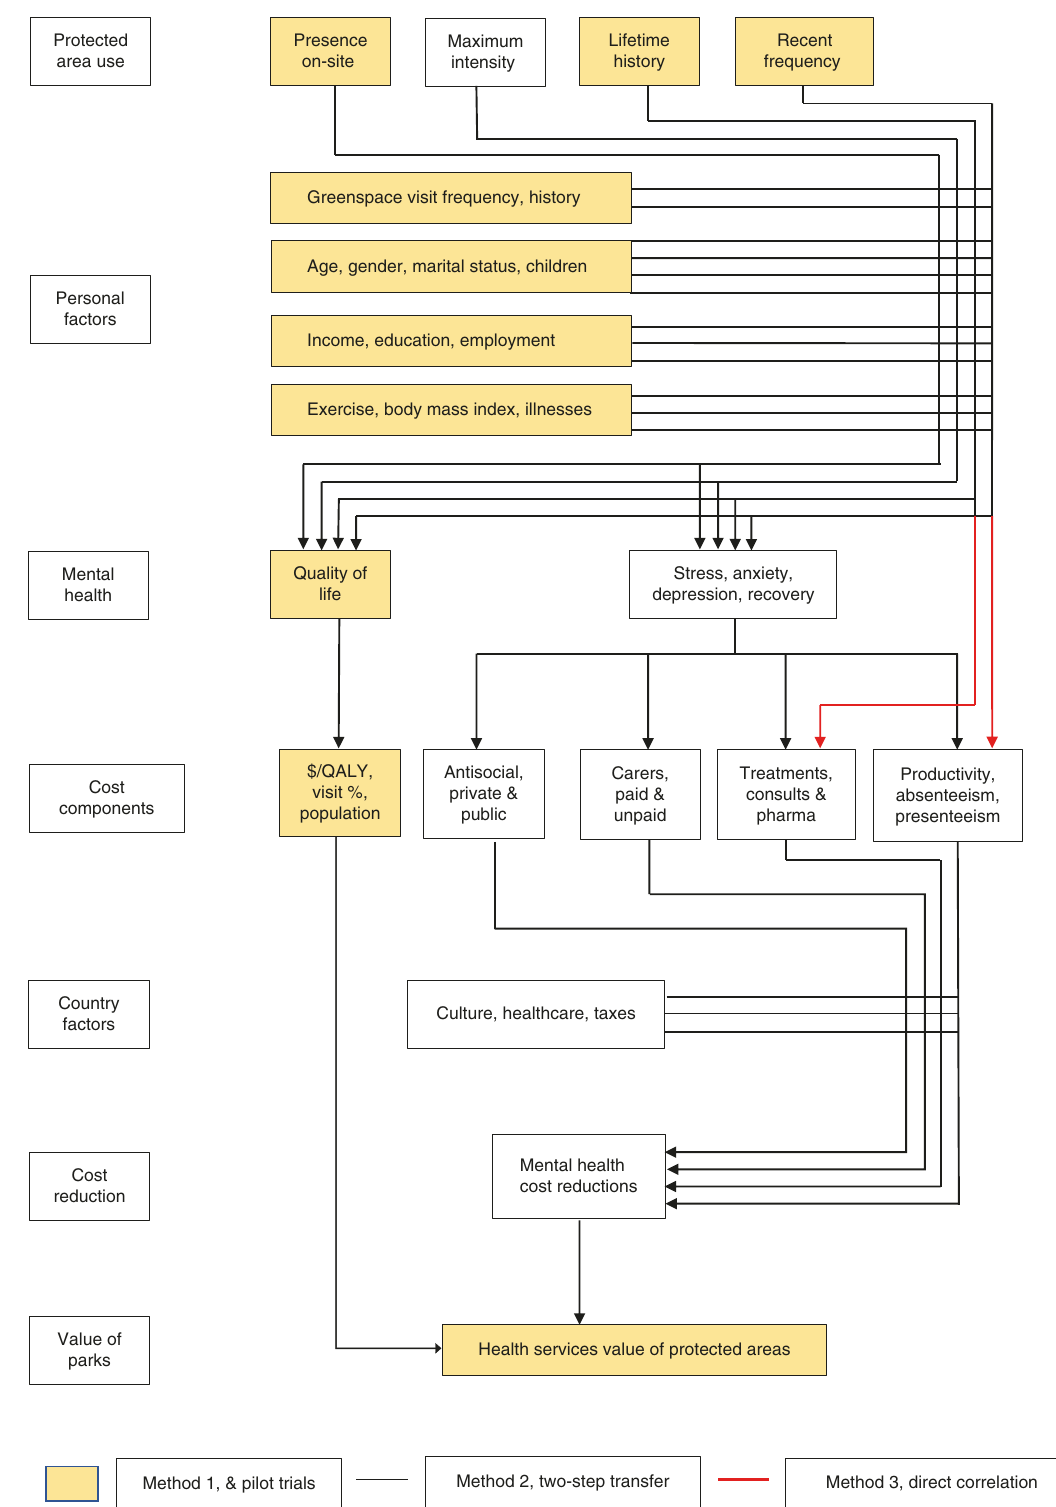
Fig. 1 Flowchart of calculation pathways for health services value of protected areas. Seven-block fl owchart of calculation pathways for health services value of protected areas, showing three major pathways. History, frequency, and intensity of protected-area visitation (block 1) affects mental health and quality of life of park visitors (block 3), but these are also affected by demographic and socioeconomic factors, physical health factors, and non-park greenspace use (block 2), which must therefore be controlled for. Costs (block 4) can be linked to mental health either via quality-adjusted life years (yellow boxes), individual cost components (black lines), or direct correlation with park visit patterns (red lines). Cost reductions (block 6) also depend on national healthcare funding systems (block 5). The health services value of protected areas (block 7) is the net reduction in aggregate costs of poor mental health, derived from visitation to protected areas. The three pilot studies presented here use the $/QALY pathway, shown in yellow boxes, with three different measures of park use (block